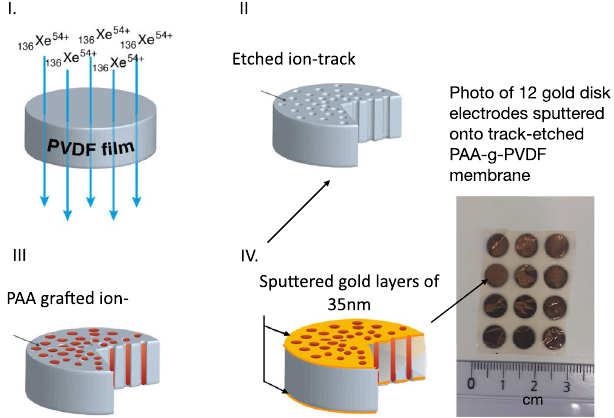
Figure 1. Fabrication steps of PAA-g-PVDF nanoporous membrane electrode: I. Swift heavy-ion irradiation 54 + of PVDF thin film using 136 Xe ions of 5.9 MeV/mau, II. Ion-track etching, III. Radiation-induced grafting of PAA inside PVDF etched ion-tracks, IV. Sputtering of a thin gold layer (35 nm) on each side of PAA-g-PVDF nanoporous membrane. Photo of 12 nanoporous gold electrodes sputtered through a home-made mask onto PAA-g-PVDF track-etched membrane